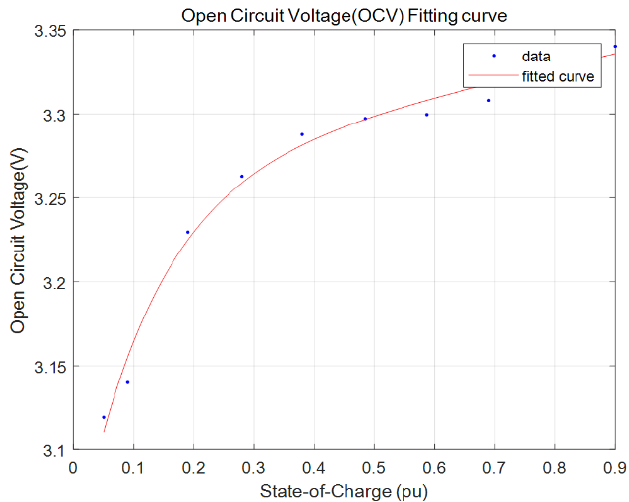
Figure 10. Battery open circuit voltage fitting curve.